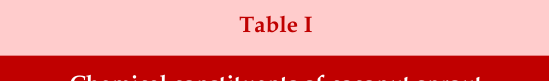
Chemical constituents of coconut sprout